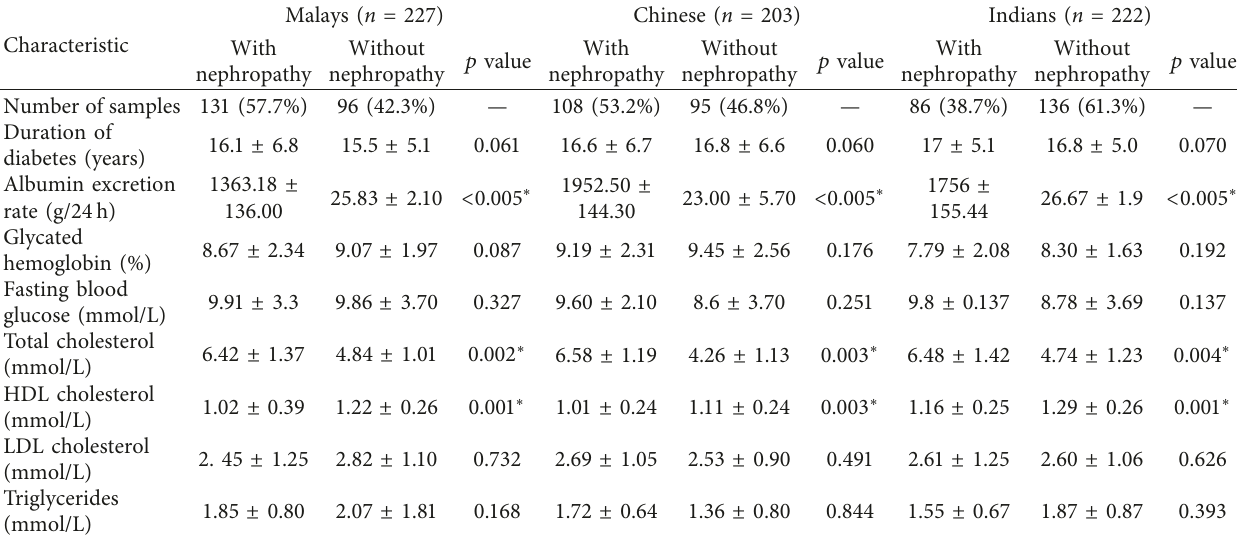
Table 3: Clinical and demographic characteristics of type 2 diabetic patient